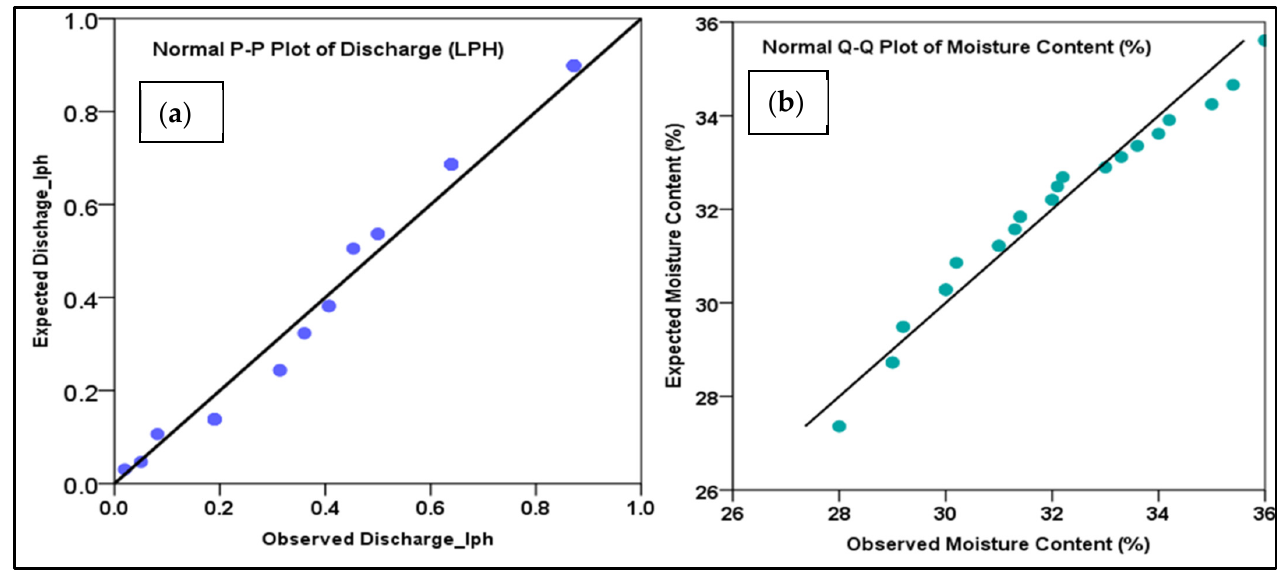
Figure 11. ( a ) Normal P-P plot of observed and expected discharge (lph); ( b ) Normal Q-Q plot of observed and expected moisture content (%).